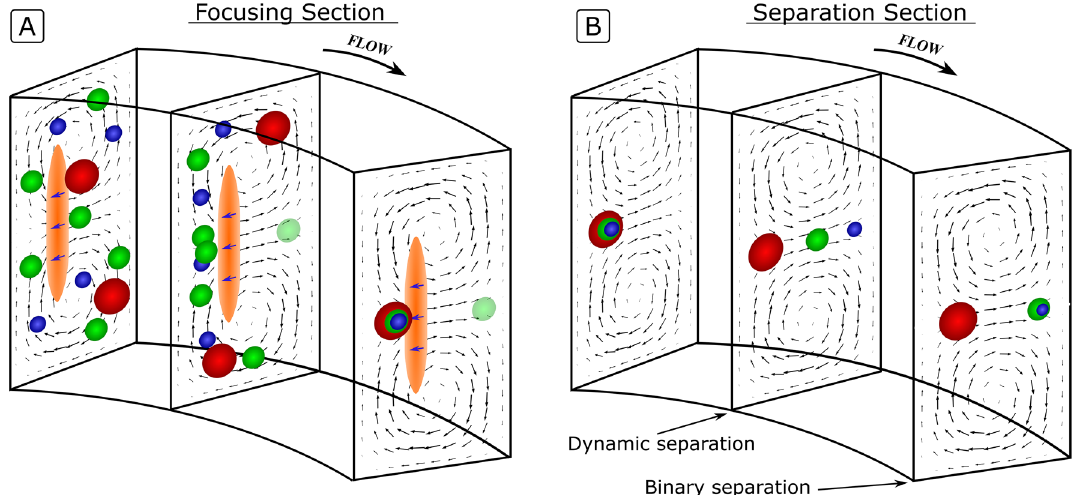
Figure 1. ( A ) 3D focusing mechanism in HARC systems. The Lift Barrier (orange ribbon) prevents particles from crossing to the outer wall, resulting in a close focus position for all sizes. ( B ) Particle separation in HARC systems. With all particles starting at a similar position, the Lift Barrier is weakened, allowing the smaller ones to migrate towards the outer